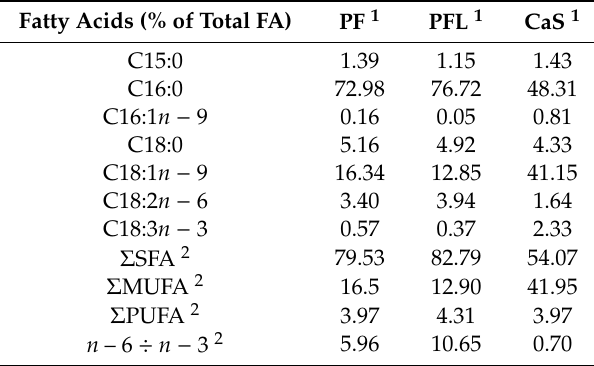
Table 1. Fatty acid composition of rumen protected fats.